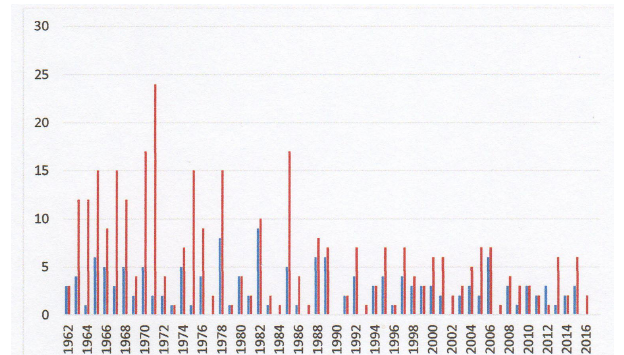
Figure 4. Ny-Ålesund launch site.